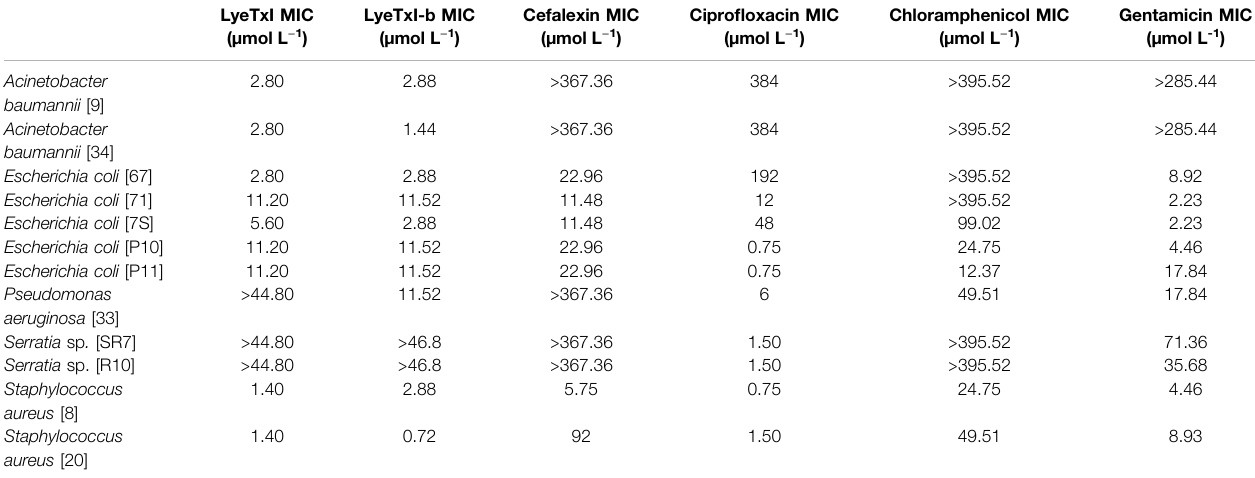
TABLE 3 | Minimum inhibitory concentration (MIC) values for LyeTxI and LyeTxI-b in planktonic bacteria.